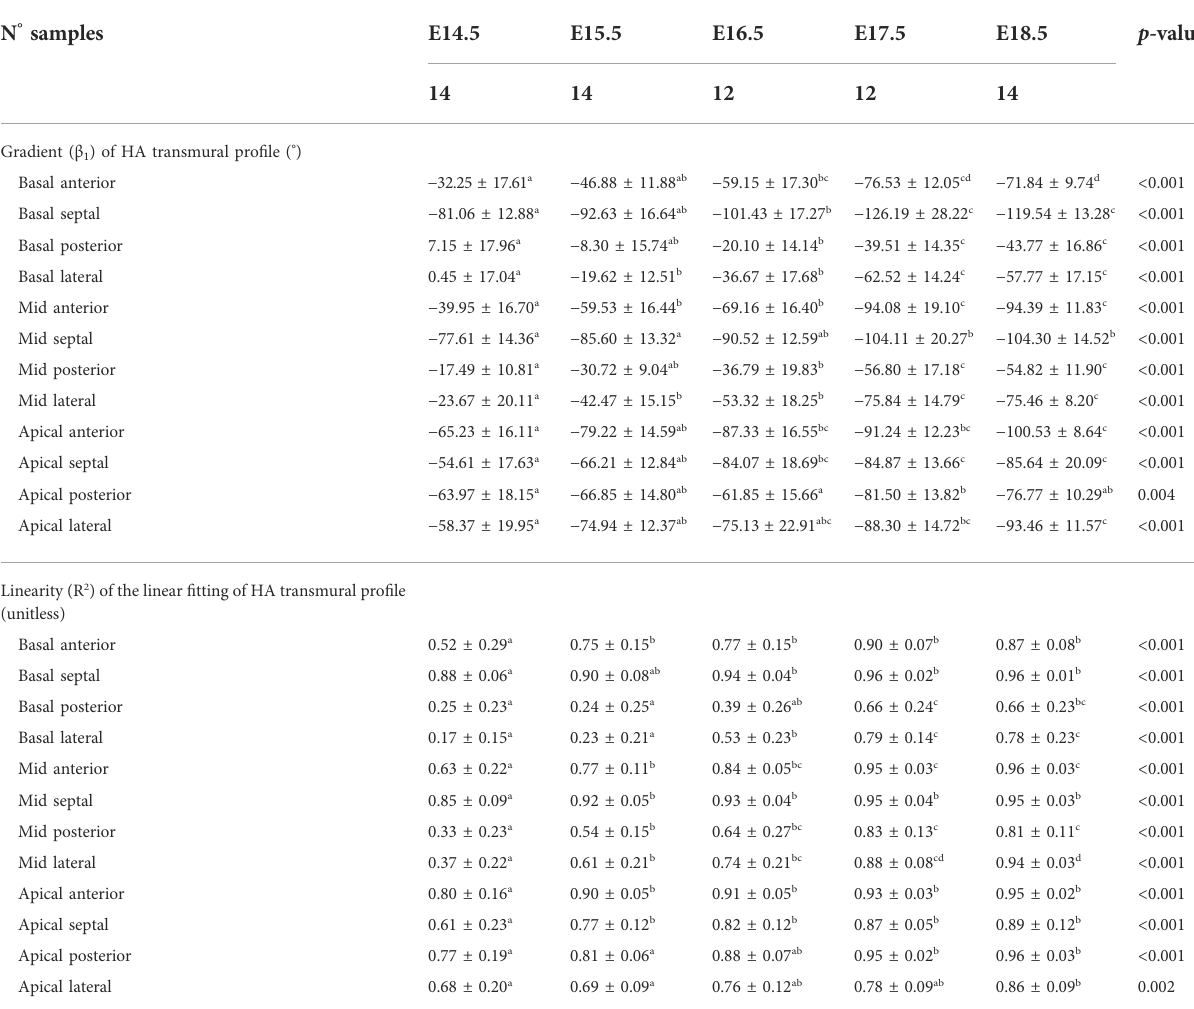
TABLE 2 Parameters of the linear fi tting: y = β 1 · x + β 0 , of helical angle (HA) transmural pro fi le within the left ventricle (LV), expressed as mean ± standard deviation. N °